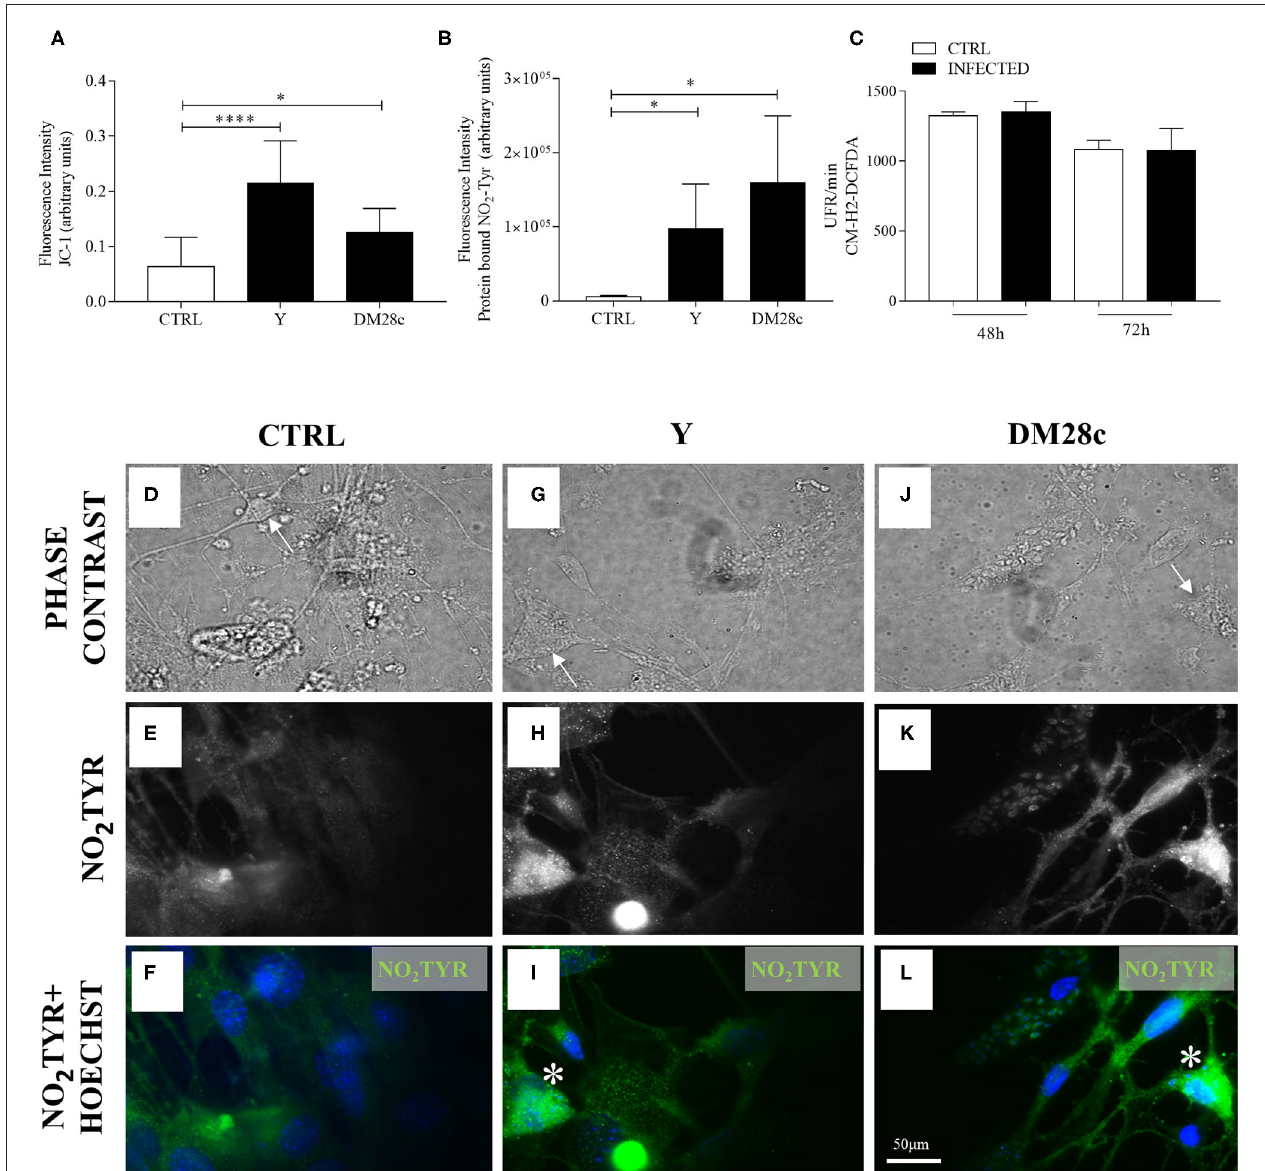
FIGURE 7 | Quantification of mitochondrial function (JC-1), nitrotyrosination, and ROS production in primary enteric neuronal cultures. Neurons removed from the myenteric plexus were dissociated, plated, and infected or not with T. cruzi strains Y and Dm28c trypomastigotes and followed up for 72h. (A) Quantification of fluorescence intensity for JC-1. n = 6. Data are representative of three independent experiments in triplicate coverslips (B) Quantification of anti-3-NO 2 -tyrosine antibody (NO 2 TYR); (C) Fluorescence (in relative fluorescence units, RFU) of the oxidized CM-H 2 DCFDA probe. n = 4. Data are representative of two independent experiments in duplicate coverslips. Phase contrast images of (D) Control (CTRL); (G) Infected with the Y strain; (J) infected with the Dm28c strain. (E–L) Immunofluorescence for NO 2 TYR. After fixing the coverslips in a 4% buffered paraformaldehyde solution, they were incubated with anti-3-NO 2 -tyrosine (green) and photographed under a fluorescence microscope (Nikon Eclipse TE 200). Cell nuclei were identified using the Hoechst marker (blue). Scale bar: 50 µ m. 40X Objective. Student t -test. Difference in relation to the control group, P < 0.05 (*) P < 0.0001 (****). Data are shown as mean and standard deviation (SD). Arrows indicate neuronal bodies. Asterisk indicates strong immunofluorescence of nitrotyrosine in neurons.